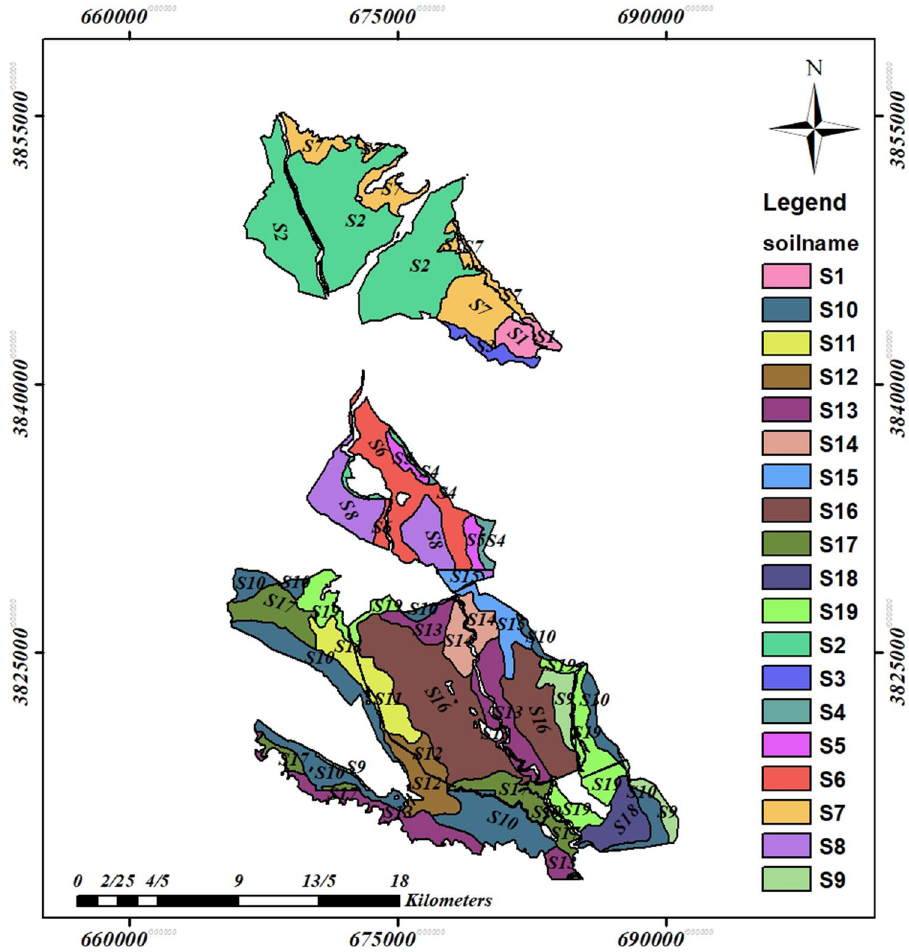
Fig. 3 Location of soil units (coordinate system: UTM, Zone 38